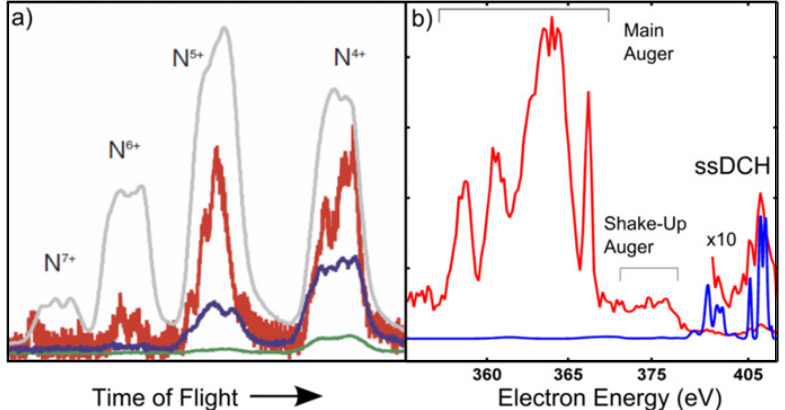
Figure 3. a) Nitrogen charge state distributions following intense x-ray ionization, demonstrating the phenomenon of frustrated ionization. The red, blue, and green curves all have pulse energies of approximately 0.25mJ, and pulse durations of 280 fs, 80 fs, and 5–10 fs, respectively. The nitrogen molecules become relatively transparent to x-rays when both 1 s electrons have been ionized faster than Auger relaxation can refill them. Therefore shorter pulses cannot strip as many electrons from the atoms as longer pulses with the same photon fluence. The grey curve is a longer pulse with 2.2mJ to show the reference spectrum. (Adapted from Hoener et al. [7]). b) Auger electron spectra obtained using the shortest x-ray pulses. The large feature spanning energies of 355 eV to 365eV correspond to normal Auger following creationg of a single core vacancy. The single-site double core vacancy Auger spectrum is centered on 405eV. The blue curve is a calculation (adapted from Cryan, et al.